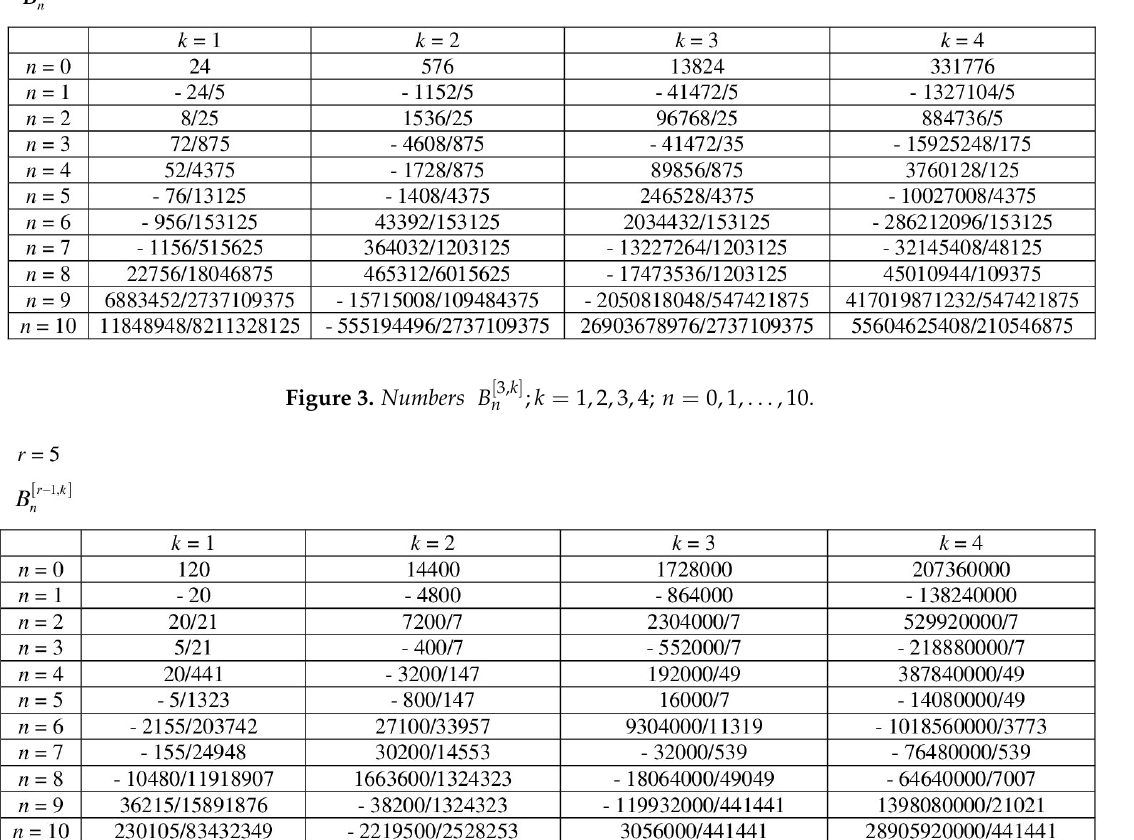
Figure 4. Numbers B